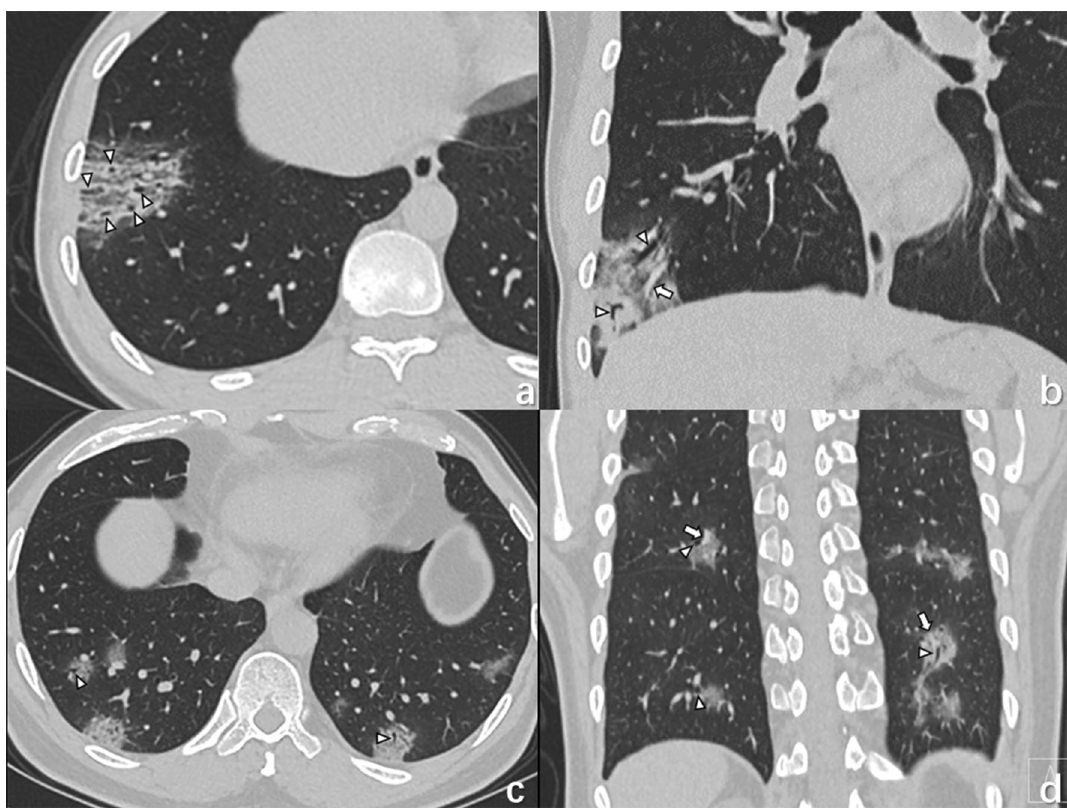
Figure 3. ( a , b ) A 35-year-old male with COVID-19 infection presenting fever and headache for 1 day. CT images shows small vascular enlargement (arrows) and bronchiolectasis (triangles) in GGO, as well as multiple GGOs in the subpleural areas of bilateral lung. ( c , d ) An 80-year old man with COVID-19 infection, who lives in Wuhan presented with fever and dry cough. CT images shows multiple patchy areas of GGOs as crazy-paving pattern with bronchiolectasis (triangles) and vascular enlargement (arrows).